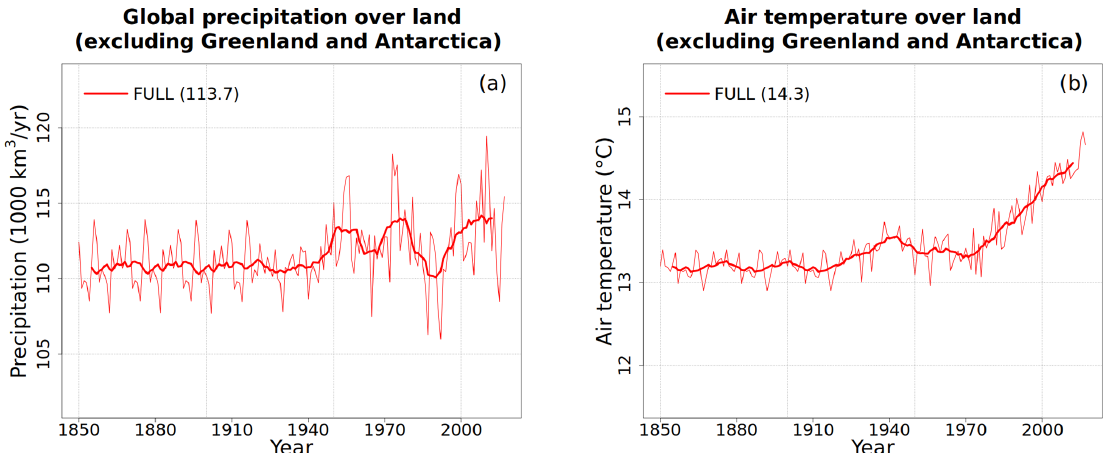
Figure A2. Annual values of global precipitation (a) and air temperature (b) over land in the CRU-JRA reanalysis data that are used to drive the model. The data are available for the period 1901–2017. In the absence of meteorological data for the period 1851–1900, data from the period 1901–1925 are used twice. The thin lines are the annual values, and the thick line is their 10-year running mean. The values in the parentheses in the legend show average values over the last 20